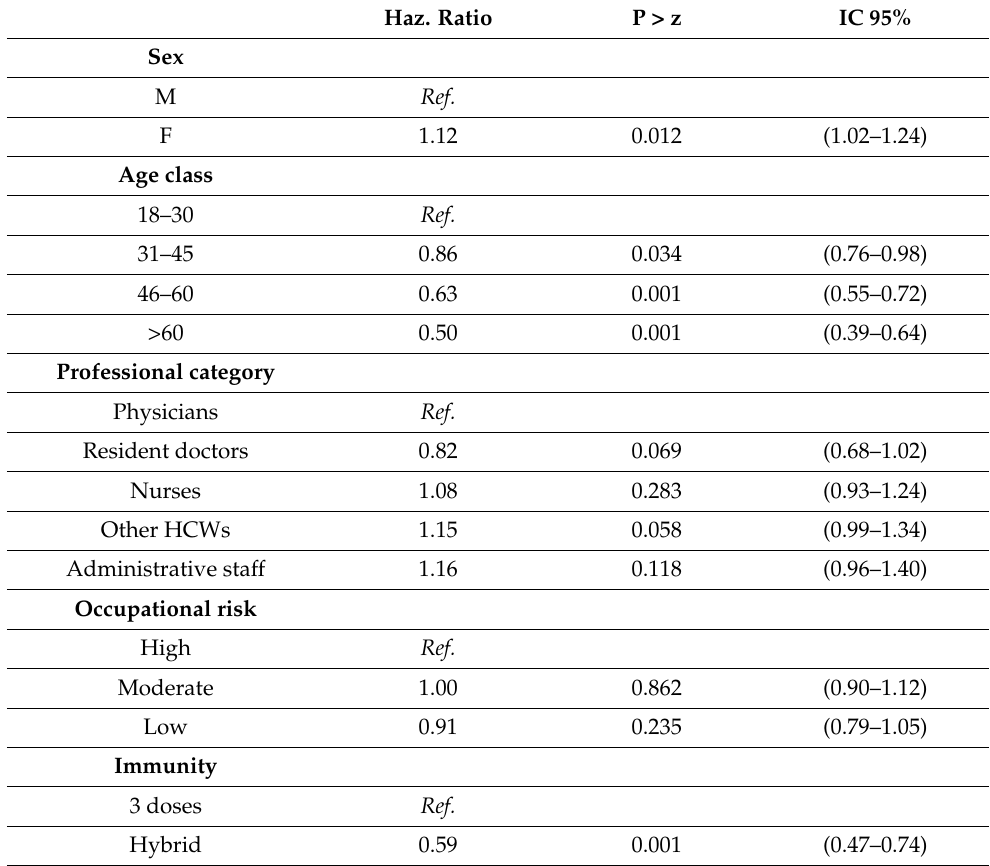
Table 3. Cox regression model: factors associated with SARS-CoV-2 infections after the booster dose. Haz.